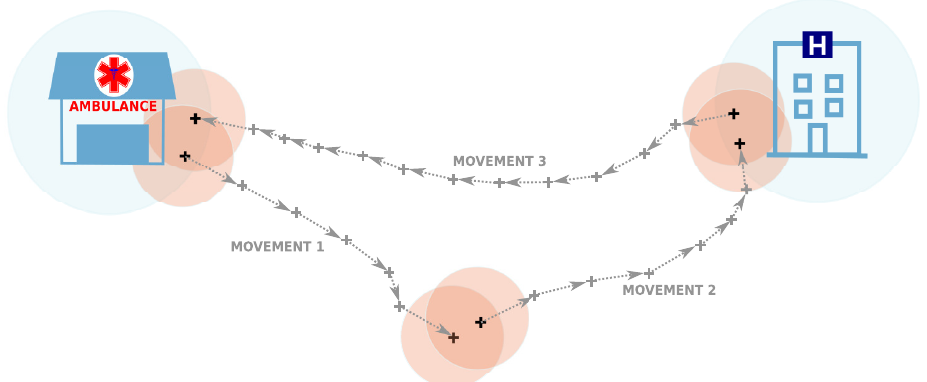
Figure 3. An illustration of a trip that originates and terminates at the ambulance station and is formed by three co-located movements. First, GPS measurements should be combined to form movements; secondly, a trip should be constituted from a sequence of co-located